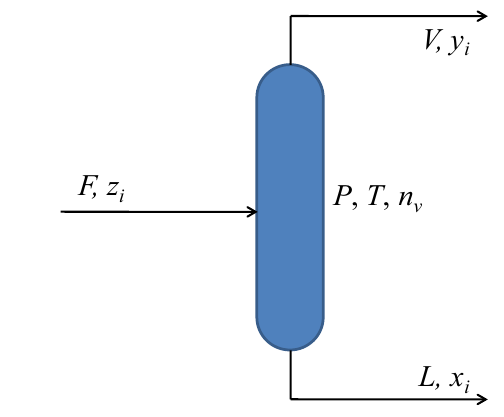
Fig. 4 Vapor–liquid equilibrium for flash calculation